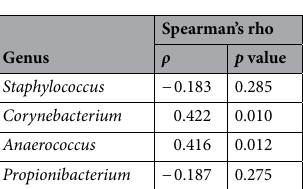
Figure 4. Shifts in the axillary microbiome of the bioconverted product (BLC) and placebo. Canonical analysis of the principal coordinates of the axillary microbiome in relation to the odor intensity and time point in the ( A ) BLC and ( B ) placebo groups. ( C ) The Chao1 index of each group. Paired t-test used to compare the Chao1 index. The color code and size of the canonical analysis of principal coordination analysis are the group and odor intensity, respectively.